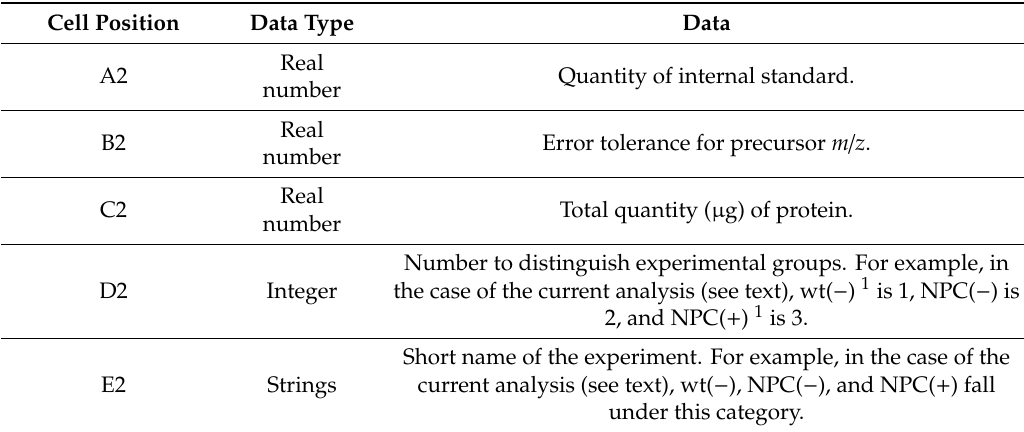
Table 2. Metadata for Glycan Analysis Using TAG Expression.